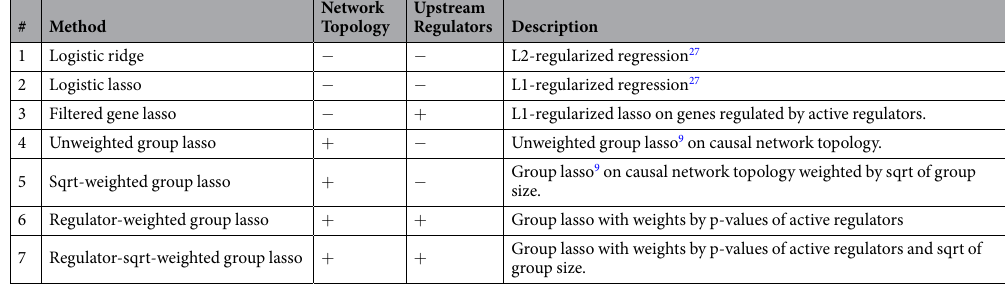
Table 1 gives an overview of the benchmark methods. Ridge (#1) and lasso (#2) logistic regressions are pop- ular approaches for phenotypic prediction 27 . To assess the impact of feature selection by the upstream regulator detection method, we also defined the Filtered Gene lasso (#3). In this method, we simply restrict the input transcriptomics data to genes that are regulated by active upstream regulators. Finally, we consider the four group lasso-based approaches defined in the previous section. All parameters for detection of upstream regulators are the same across methods. For a fair comparison between methods, input train and test gene expression data are filtered to include only genes that are present in the network of gene regulatory interactions. The lasso and ridge regression models were trained using the R glmnet package 27 . Nested cross-validation vs. independent data sets. In all methods under study, internal parameters such as the lasso regularization parameter λ in (1) or the tradeoff parameter α in (7) must be fit. In addition, we perform a feature selection based on upstream regulator detection prior to classification. The literature abounds with arti- cles in which this situation is inappropriately handled by simple cross-validation. For instance, one could detect transcripts regulated by active regulators on the complete dataset and subsequently employ a cross-validation procedure for the regularized classifier only. This will lead to a strong overestimation of expected classification performance 28 .